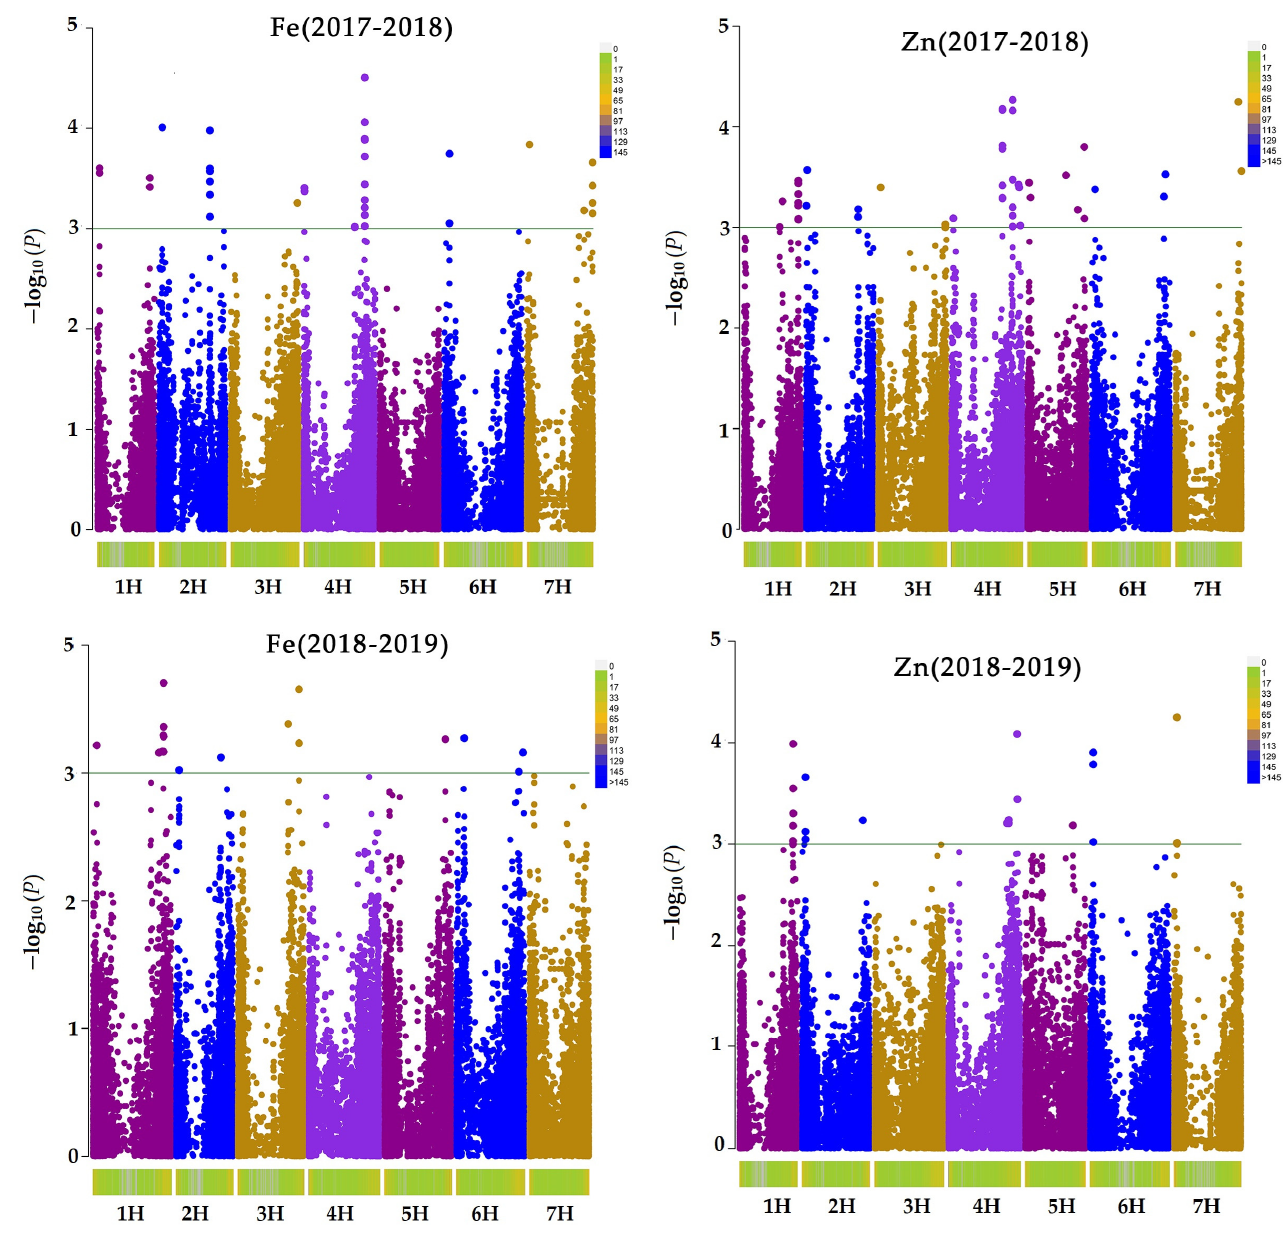
Figure 4. The Manhattan plot reveals significant SNPs ( p < 0.001) associated with Fe and Zn content. The ( − log 10 p ) values on the Y-axis are plotted against the chromosome position on the X-axis. The threshold is the blue horizontal line set at − log 10 p = 3. Table 2. Annotation of significant SNPs associated with Zn using BARLEX, BarleyVarDB and Barleymap database; for a complete list, see Supplement Table